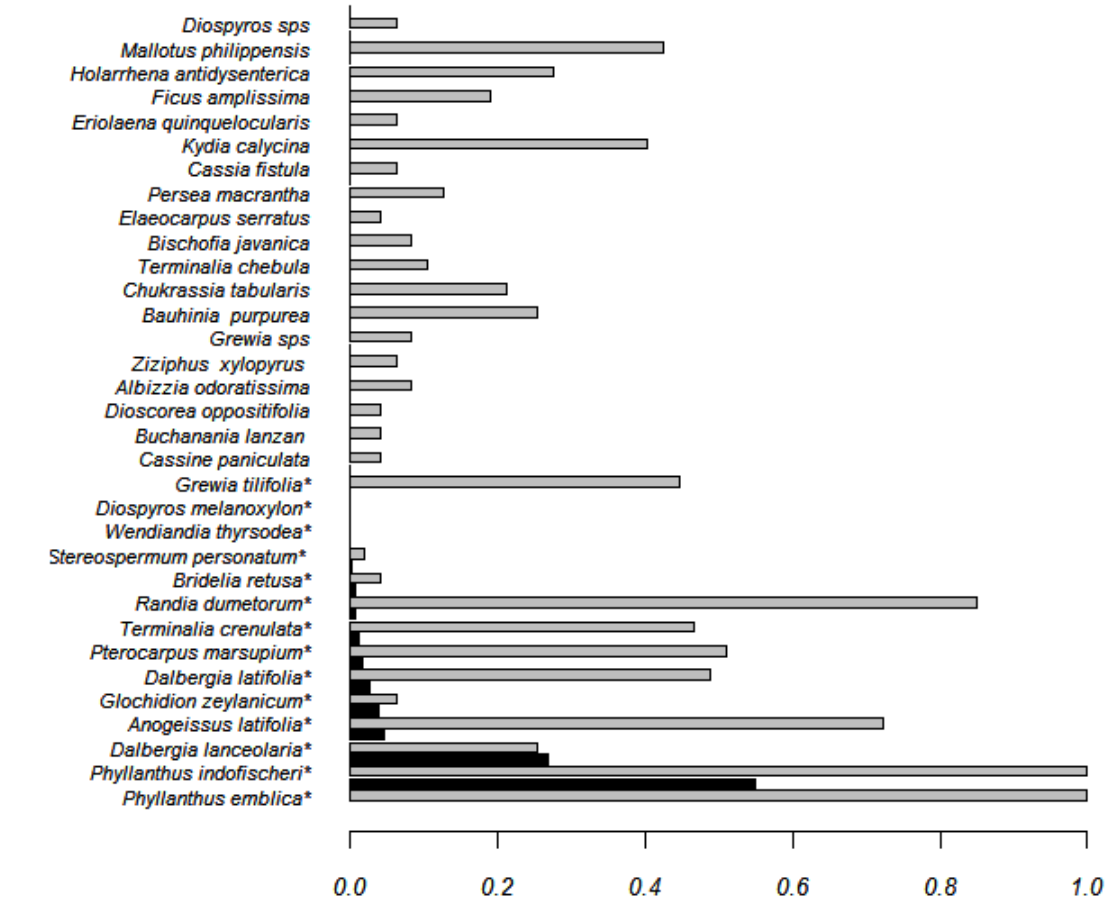
Fig. 2. Host species for mistletoe ( Taxillus tomentosus ), identified by interviews and forest surveys. Harvesters cited an average of 8.5 (± 2.7) species each. Grey bars indicate the proportion of harvesters (n = 47) citing each species. Black bars indicate the proportion of the total number of observed mistletoe infections (n = 512) attributable to a particular host. Asterisks indicate hosts identified in forest